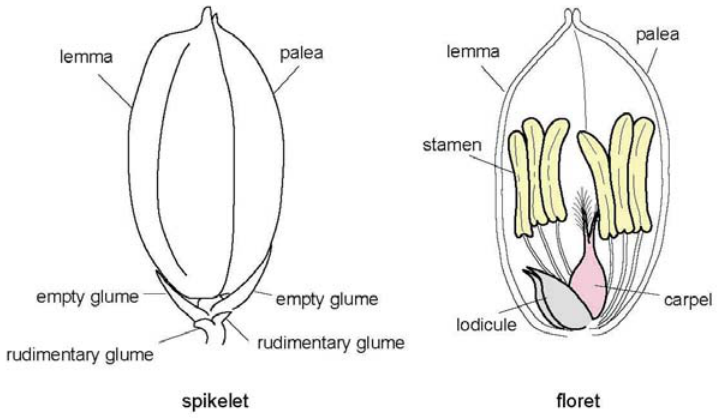
FIGURE 2. Morphology of the spikelet and floret in rice. The spikelet shows an outward form and the floret shows floral organs inside of the palea and